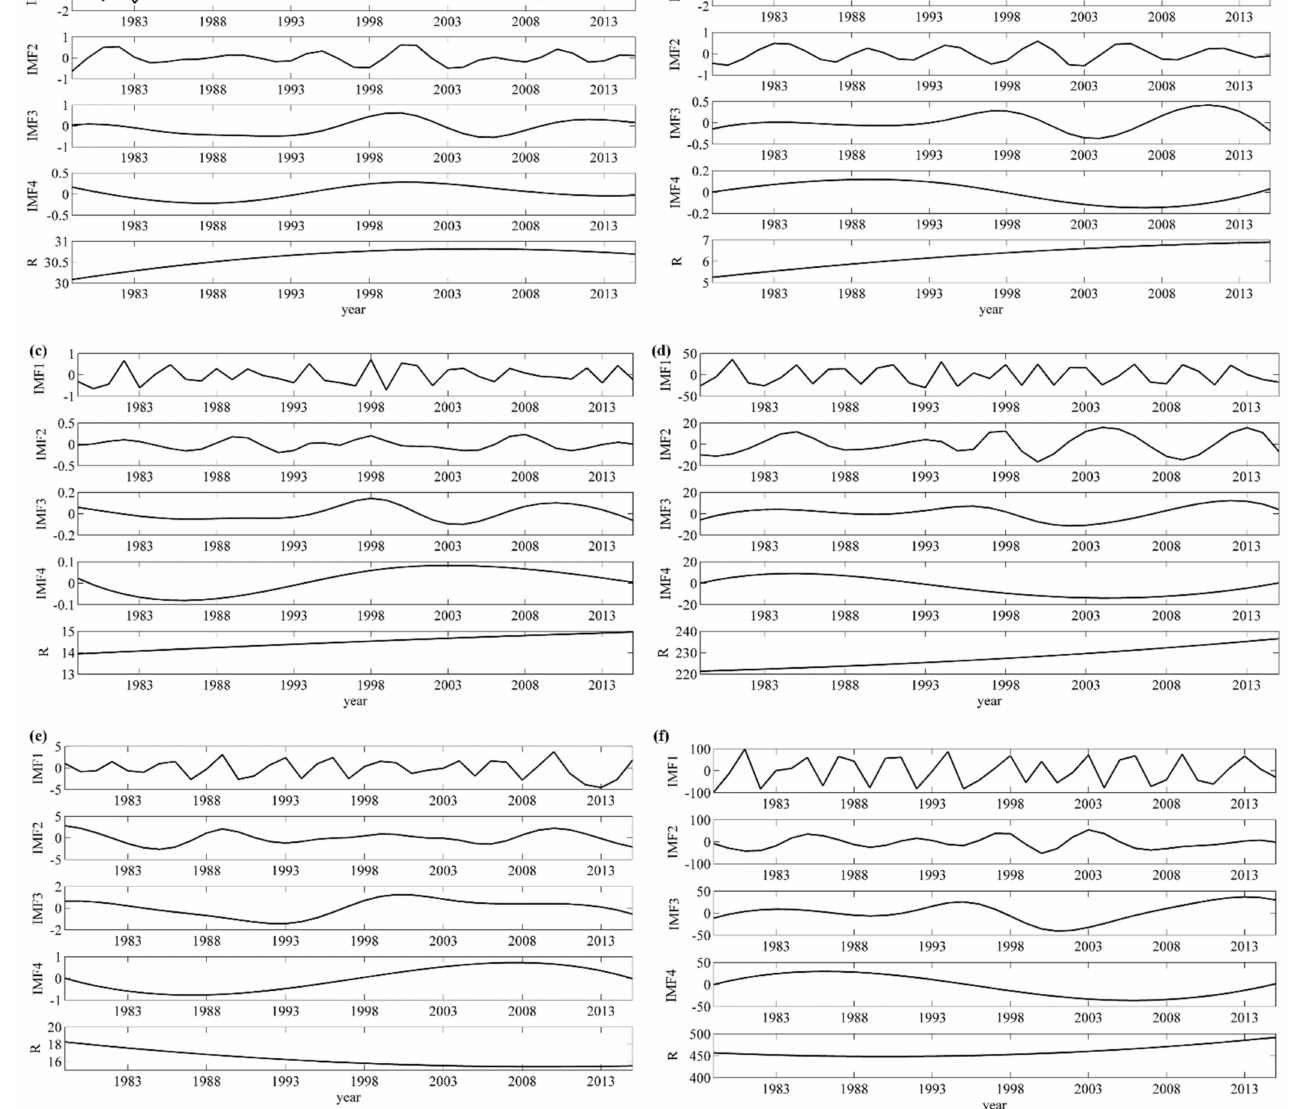
Figure 4. The temporal changes in seven main influencing climatic factors (GSMAT, GSMT, GST, GEP, CDD, and GSP, respectively corresponding to subplots ( a – f ) during 1979–2015 at different timescales based on the EEMD